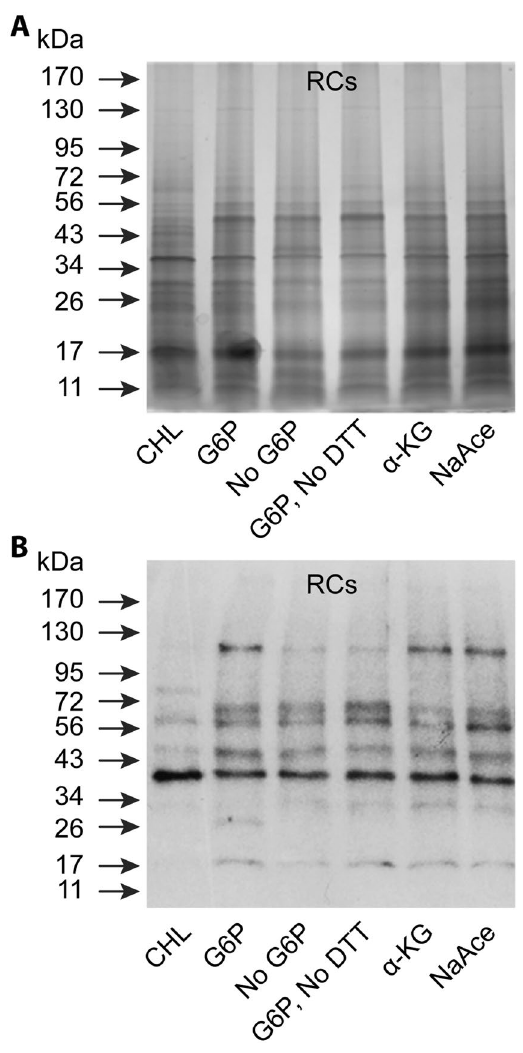
Figure 6. Protein biosynthesis assessed by protein fractionation and Western blot analysis. ( A ) Silver stained SDS containing polyacrylamide gel-resolved protein fractions were assessed for the protein abundance variations in RCs incubated in the axenic media with different carbon sources as in Fig. 5. ( B ) As in panel A, except that the resolved proteins were transferred to a nylon membrane and assessed by Western blot analysis using mouse polyclonal serum against E . chaffeensis